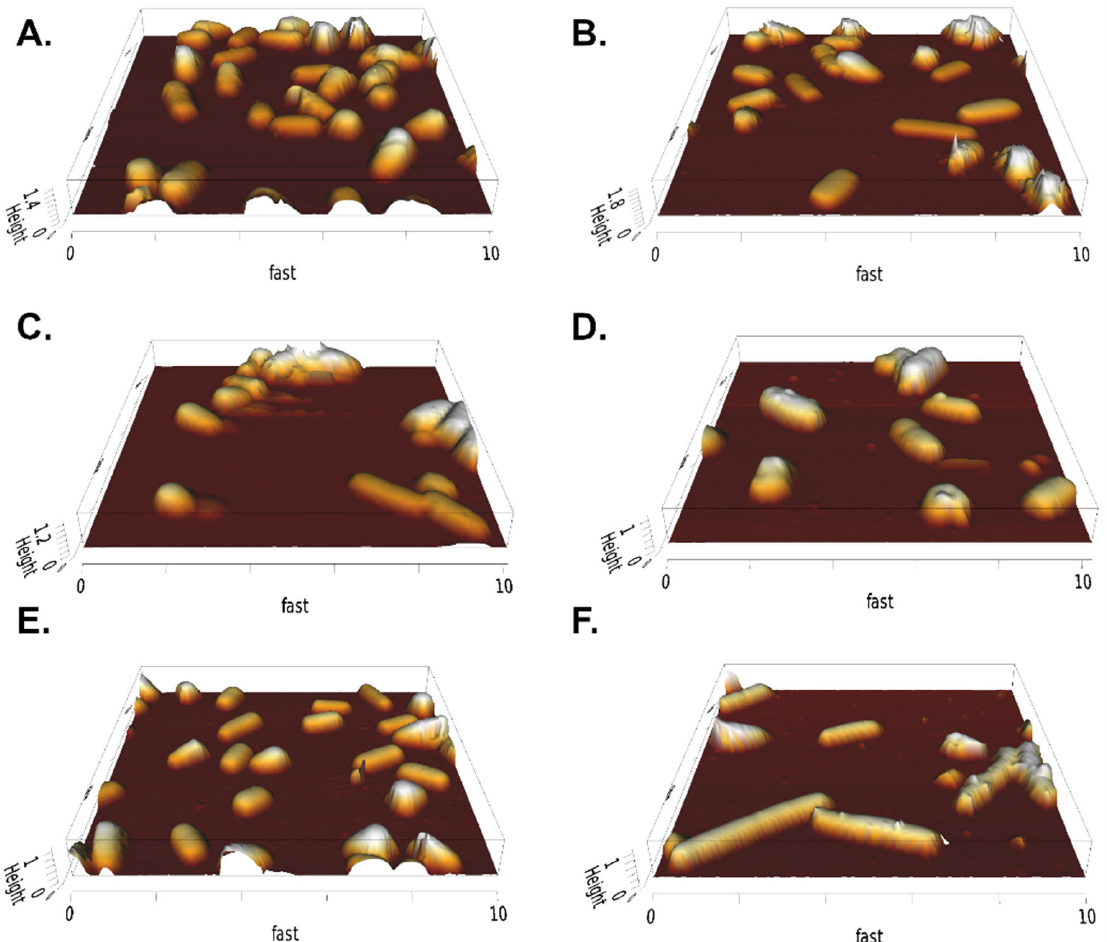
Figure 3. AFM imaging of bacterial cells immobilized on PEI ‐ coated glass slides in PBS. The left column shows REF with growth times of ( A ) 3 h, ( C ) 19 h, and ( E ) 31 h, while the right column shows the PEP with growth times of ( B ) 3 h, ( D ) 19 h, and ( F ) 31 h.